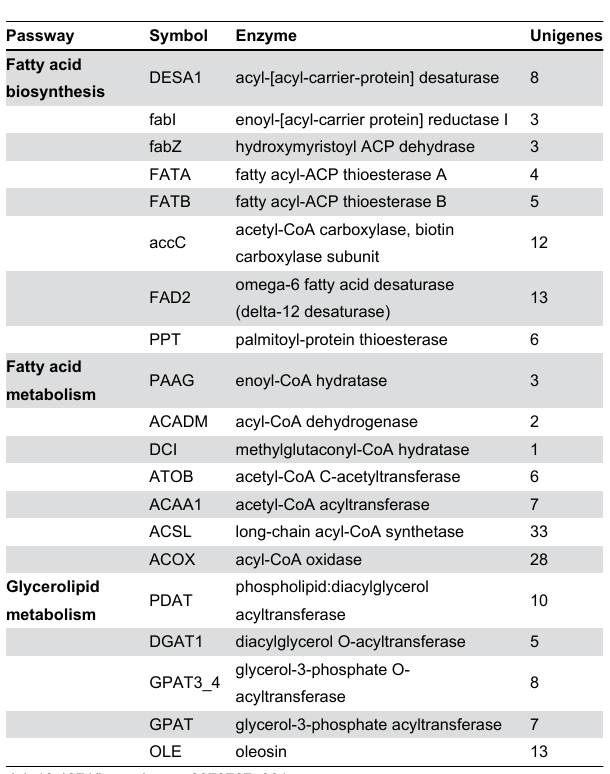
Table 1. The main Enzymes related to oil accumulation and metabolism in peanut